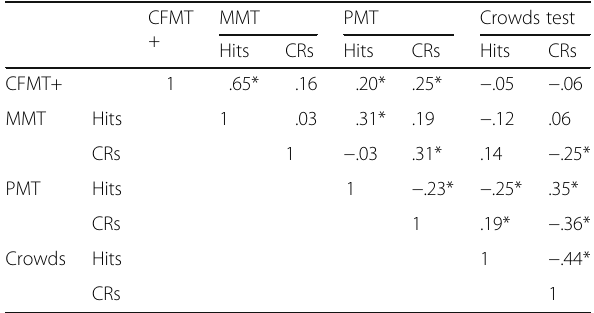
Table 6 Correlation matrix for the experimental group ’ s performance on the four face recognition tests, including hits and correct rejections